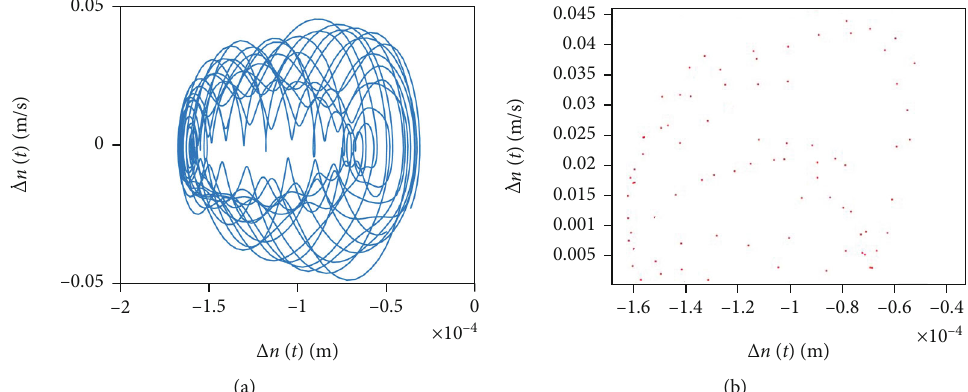
Figure 32: When the rotation speed of the system is 4200r/min: (a) relative displacement velocity and (b) the corresponding diagram of Poincare.